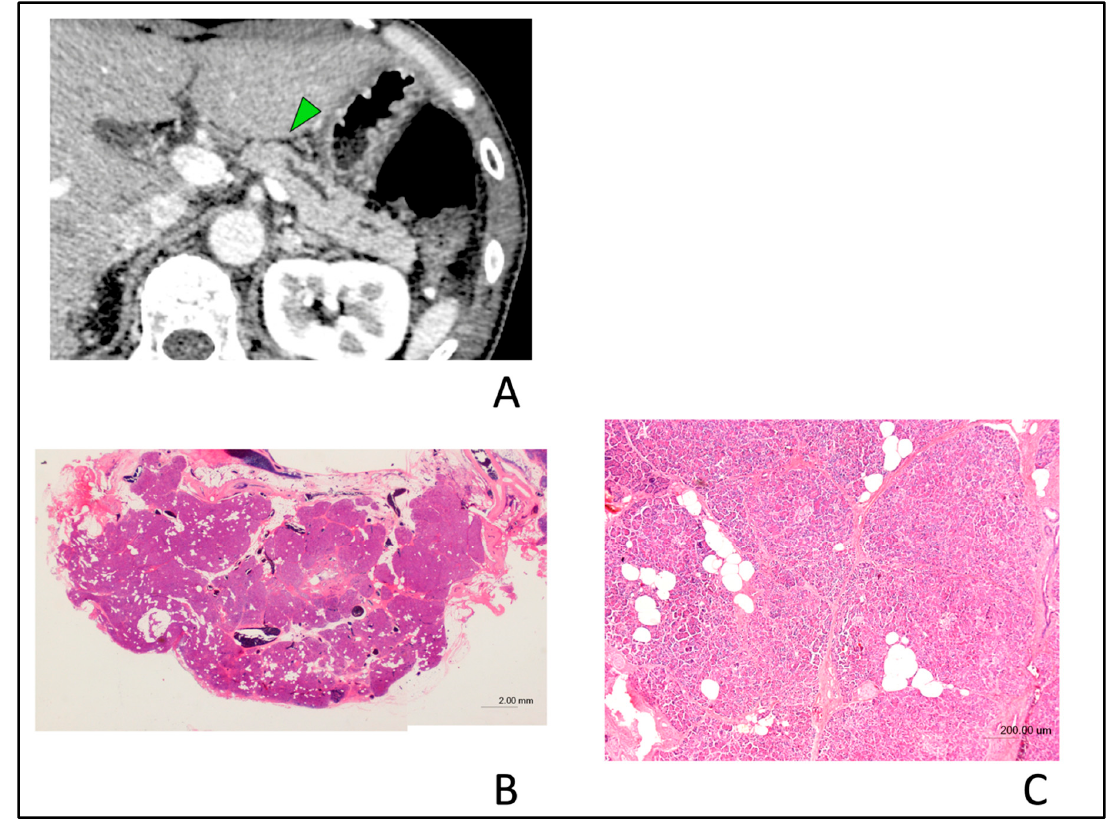
Figure 8. Typical computed tomography (CT) images showing non-atrophic parenchyma in a 55-year-old man with benign main pancreatic duct (MPD) stenosis. Localized MPD stenosis without tumor lesion was detected in the pancreatic body in CT after the recurrence of acute pancreatitis. ( A ); Typical CT images showing non-atrophic parenchyma. Non-atrophic parenchyma in a patient with chronic pancreatitis diagnosed in the resected specimen. CT image shows no evidence of pancreatic parenchymal atrophy regardless of the presence of isolated MPD stenosis (green arrow). ( B ); Hematoxylin and eosin (H&E)-stained resected specimen in the section of MPD stenosis area. Histopathological examination showed that acinar cell architecture was maintained (H&E stain, × 0.5 magnification). ( C ); Slight fibrosis and focal fatty change without parenchymal atrophy were observed in the pancreatic tissues surrounding stenosis MPD (H&E stain, × 4 magnification).